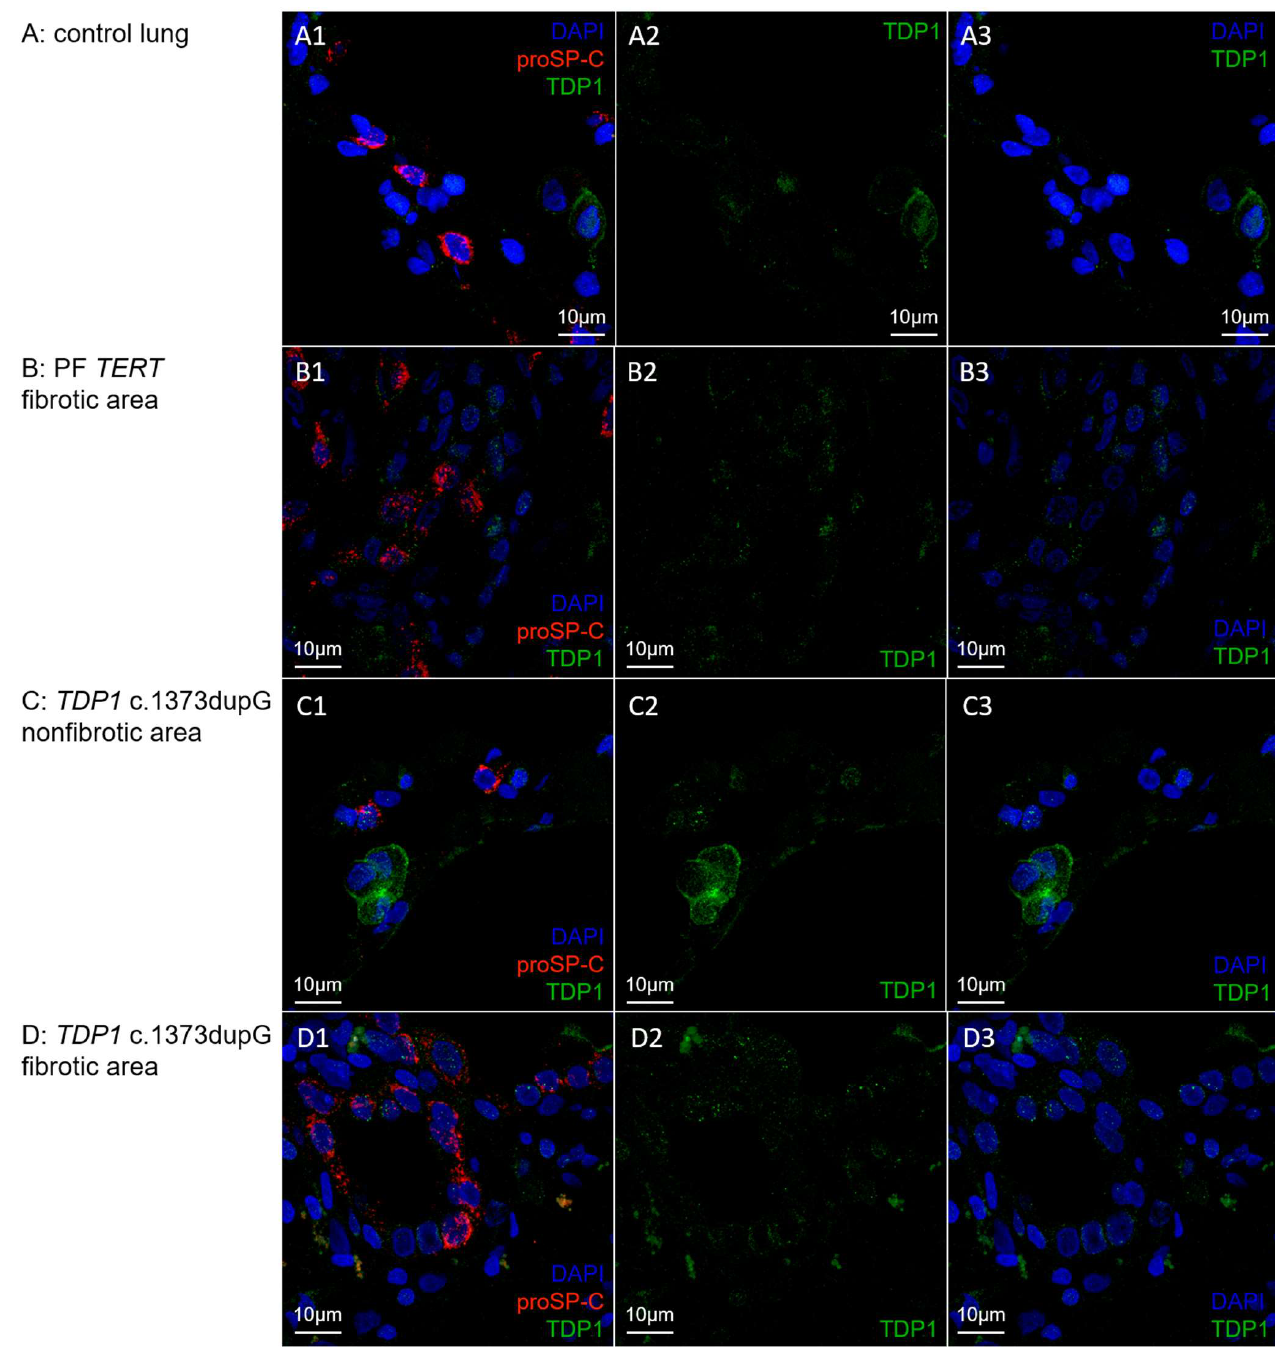
Figure 6. TDP1 protein expression in control lung ( A ), fibrotic area of PF TERT lung ( B ), and non-fibrotic ( C ) and fibrotic ( D ) lung area of TDP1 c.1373dupG variant carrier (Patient 5). ( A1 – D1 ): merge of TDP1-selective immunofluorescence staining (green), proSP-C specific staining as a marker for type 2 alveolar cells (red) and DAPI DNA staining (blue); ( A2 – D2 ): only TDP1 staining; ( A3 – D3 ): overlay of TDP1 staining with DAPI staining.